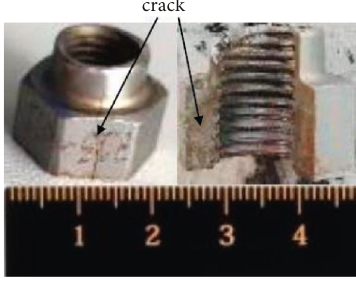
Figure 2: The condition of nut